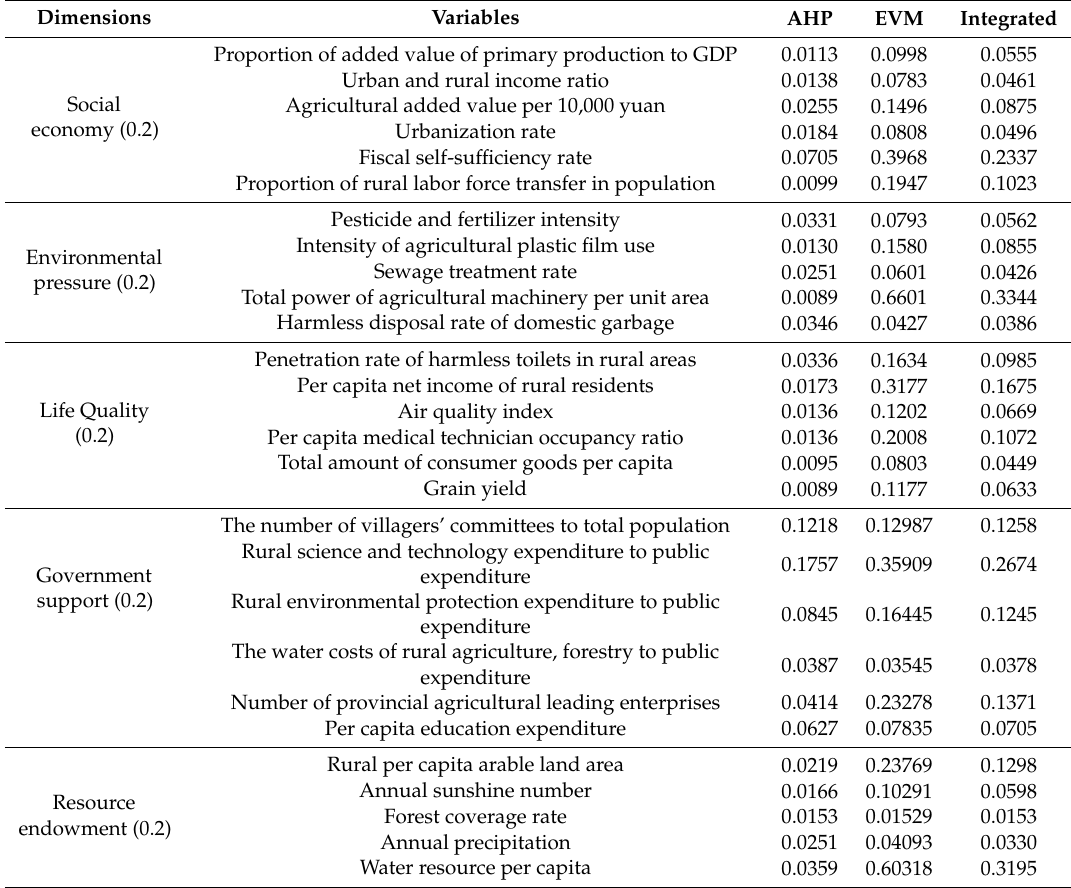
Table 2. Weights of dimensions and variables of 2018 Shaanxi’s rural